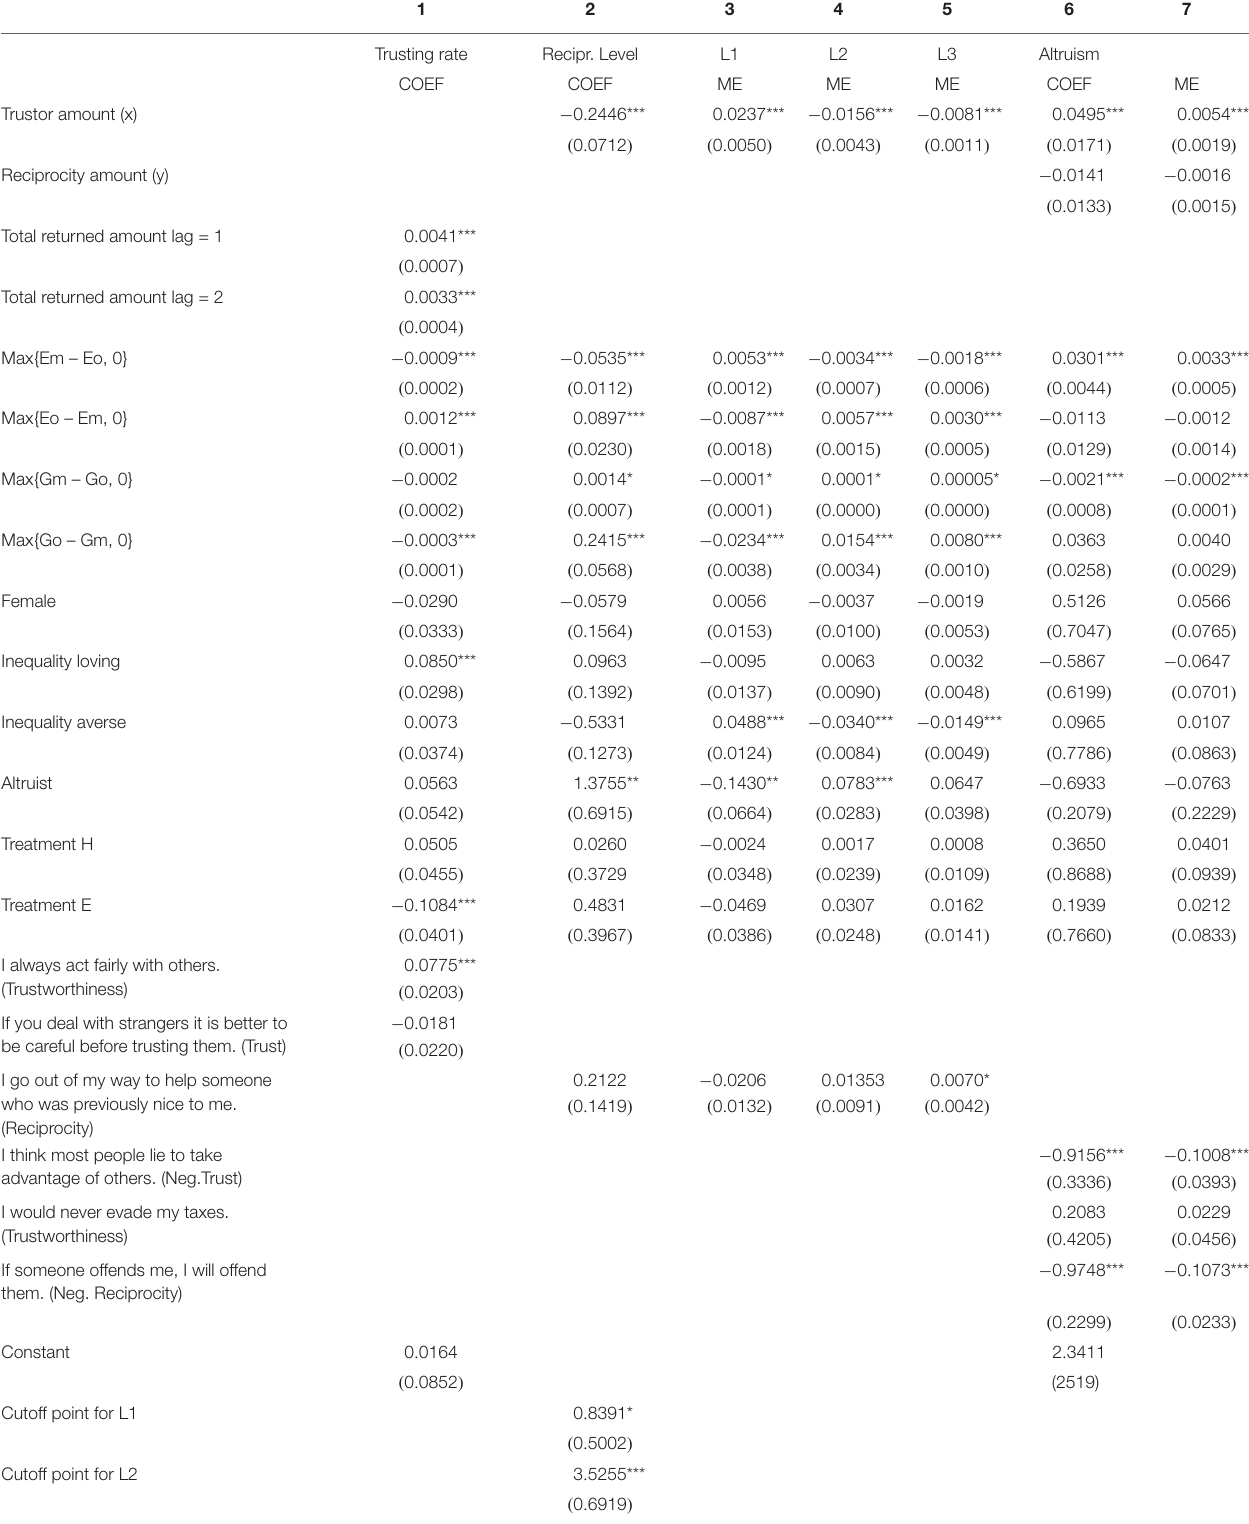
TABLE 9 | Econometric models for trustors (1) and trustees